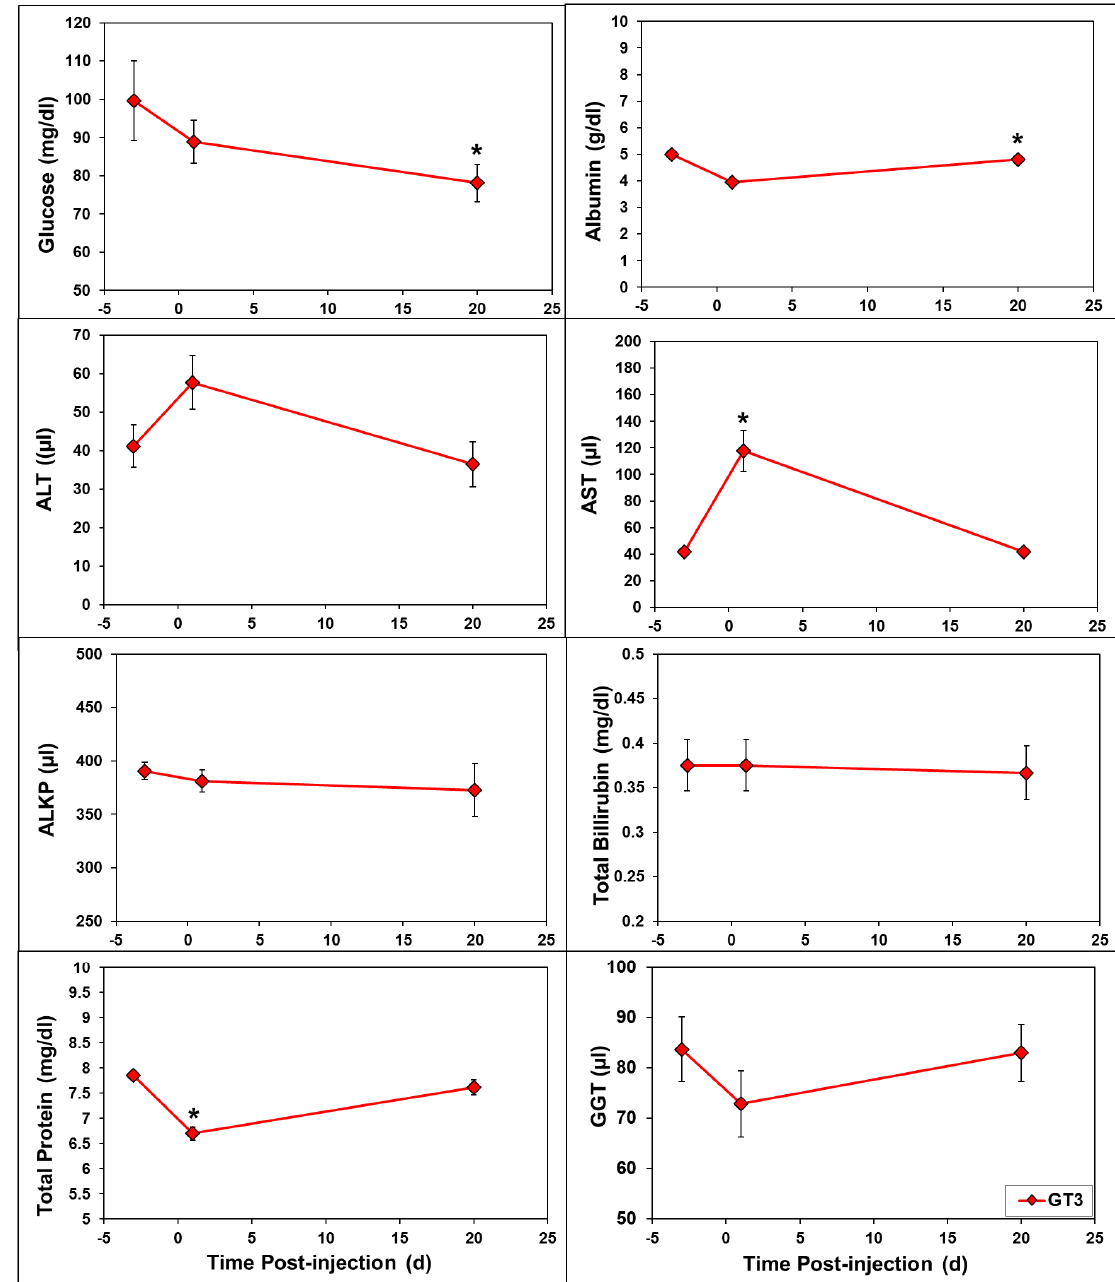
Figure 6. GT3-induced changes in serum biochemistry. GT3 was injected (sc) to NHPs. Blood was collected at various time points for serum chemistry analysis. The difference between GT3-treated doses (average of all doses) and their respective baseline measurements taken on SD-3, when significant ( p ≤ 0.05), is indicated with “ *